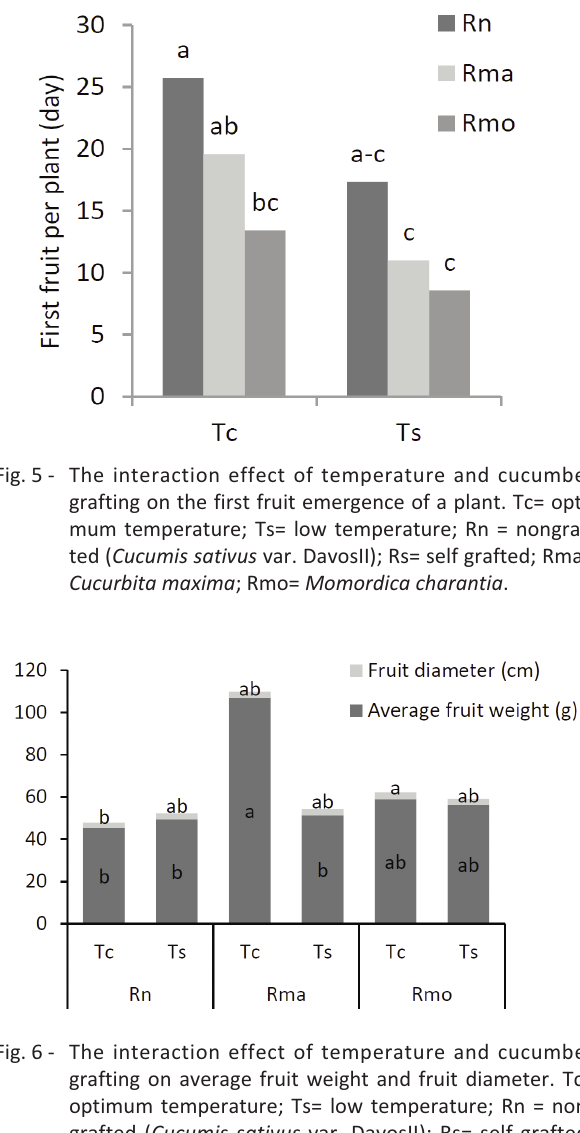
Fig. 3 ­ The interaction effect of temperature and cucumber grafting male and female flower number. Tc= optimum temperature; Ts= low temperature; Rn = nongrafted ( Cucumis sativus var. DavosII); Rs= self grafted; Rma= Cucurbita maxima ; Rmo= Momordica charantia .